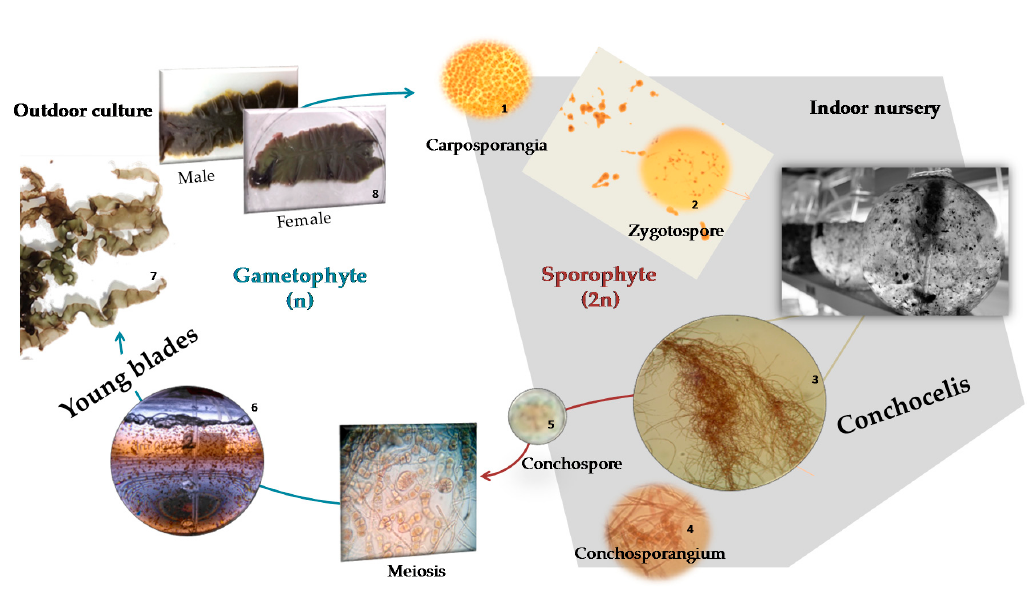
Figure 1. Porphyra dioica life cycle: the gametophytic blade phase reproduces sexually through fertilization of the carpogonium by the spermatium and subsequent formation of carpospores; the development of these spores gives rise to the filamentous sporophyte conchocelis phase, which produces conchospores that are release into the seawater and germinate to form new blades. Blades are the gametophyte phase of Porphyra spp., being the most commercially relevant stage and used mainly for the food, feed, and other high value biotechnological applications [8,9]. Porphyra species have high nutritional value and are a valuable source of a plethora of metabolites such as peptides, sulfated galactans, and polysaccharides [10], or valuable lipids such as n -3 and n -6 polyunsaturated fatty acids (PUFAs) [11]. Lipids from seaweeds are majority composed by polar lipids that are a source of esterified fatty acids (FA) [12]. Some studies suggested that they have a vast array of biological activities [13–15]. Polar lipids from Porphyra sp. were reported to display anti- macrophages through inhibition of IL-6 and IL-8 production [13,16] and antitumoral activities such as telomerase-inhibition effect [17]. However, there is still a gap on the knowledge of its lipidome and related health benefits. The early-stage filaments of Porphyra , conchocelis, are already used in cosmetics but not routinely consumed for food and are, at present, being surveyed by researchers, as